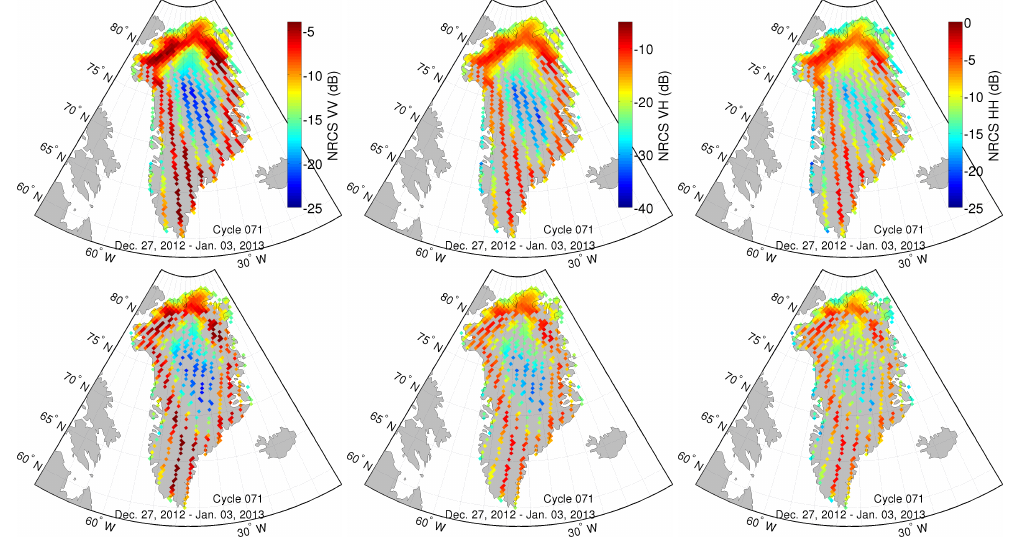
Fig. 12. NRCS (beam 3) at VV (left panels), VH (middle panels), and at HH (right panels) recorded over the GIS during the cycle 72 (3– 10 January 2013) and during ascending orbits (first row), and descending orbits (second row). Grid cells where the land fraction was less than 0.25 were masked.